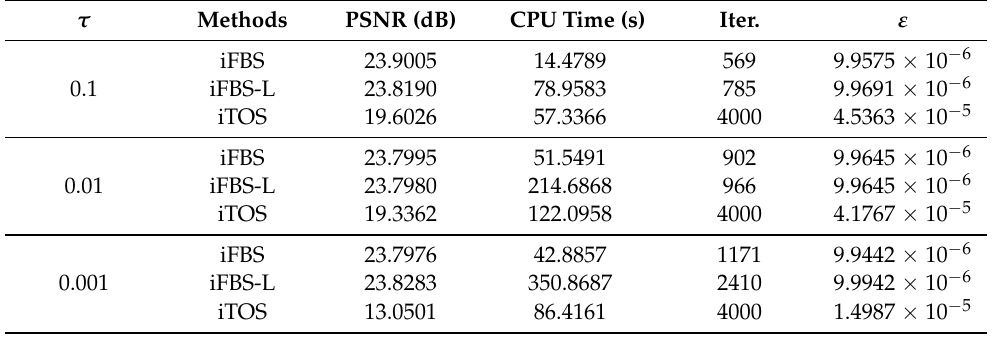
Table 2. Performance evaluation of the restored images.